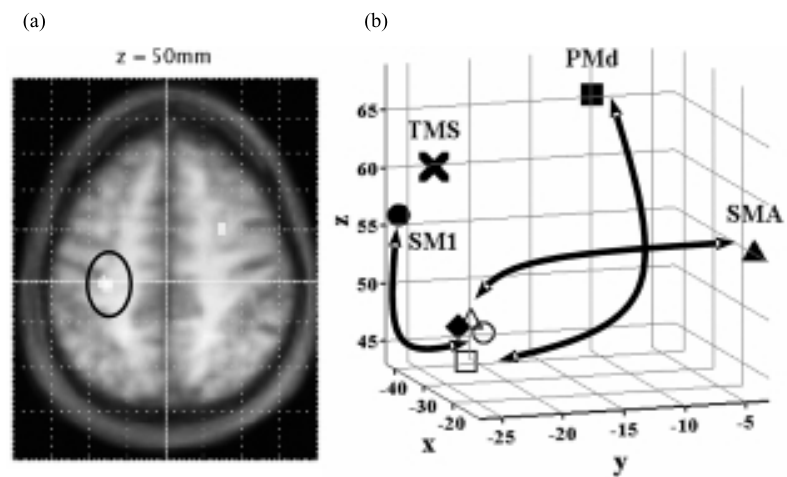
Fig. 4. Areas of the brain showing differential movement-related responses and coupling after rTMS. 4a) Increased movement related activity after 1 Hz rTMS. Results displayed on axial section of averaged anatomical MRI scans at P < 0 . 001 (uncorrected). 4b) Circle, square and triangle symbols indicating sites in primary motor cortex (open) that are more strongly coupled to activity in SM1, PMd and SMA (solid) respectively after rTMS. The solid diamond indicates the position of the SM1 site seen in 4a. ‘X’ marks the site of stimulation with 1 Hz rTMS. Adapted from Lee et al. [41]. Copyright 2003 by the Society for